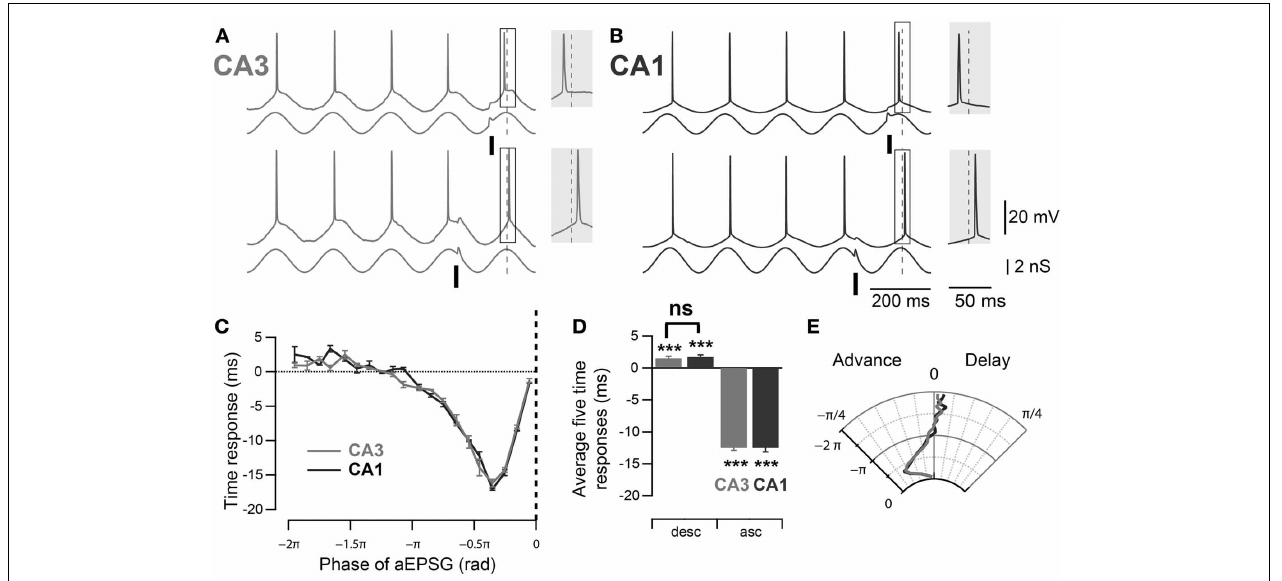
FIGURE 3 | Comparable PRCs measured at the soma of mouse CA3 and CA1 pyramidal neurons. (A,B) Representative traces, in CA3 and CA1 respectively, of spike phase shift in response to excitatory input (aEPSG) delivered at different phases of a theta oscillation imposed by dynamic clamp. When aEPSG was delivered at ascending phases, the following spike was advanced compared to the average spike phase over the four preceding cycles (top traces). In contrast, when aEPSG was delivered at descending phases, the following spike was delayed compared to the control spike phase (bottom traces). The spike phase shifts (boxes)